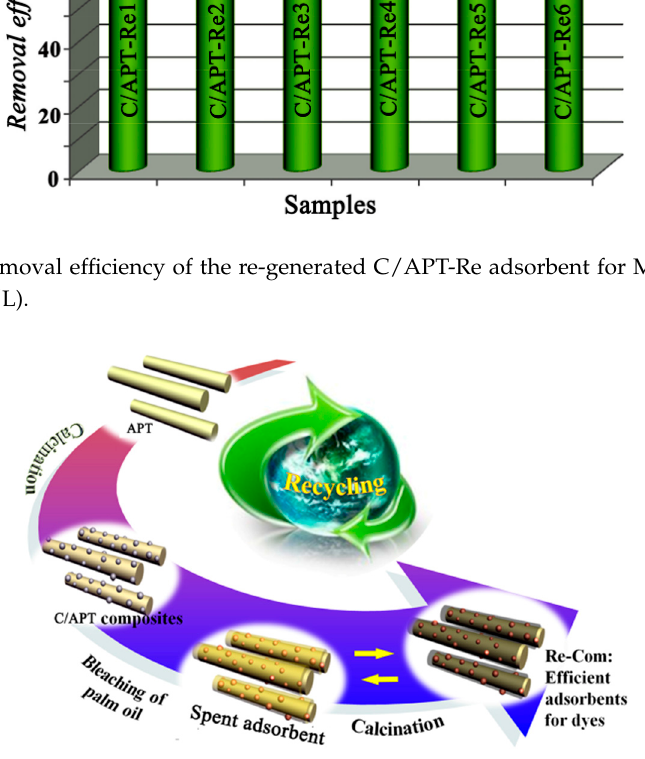
Figure 13. The cyclic regeneration and reusable route of C/APT decolorant, spent decolorant, and dye-loaded adsorbent.